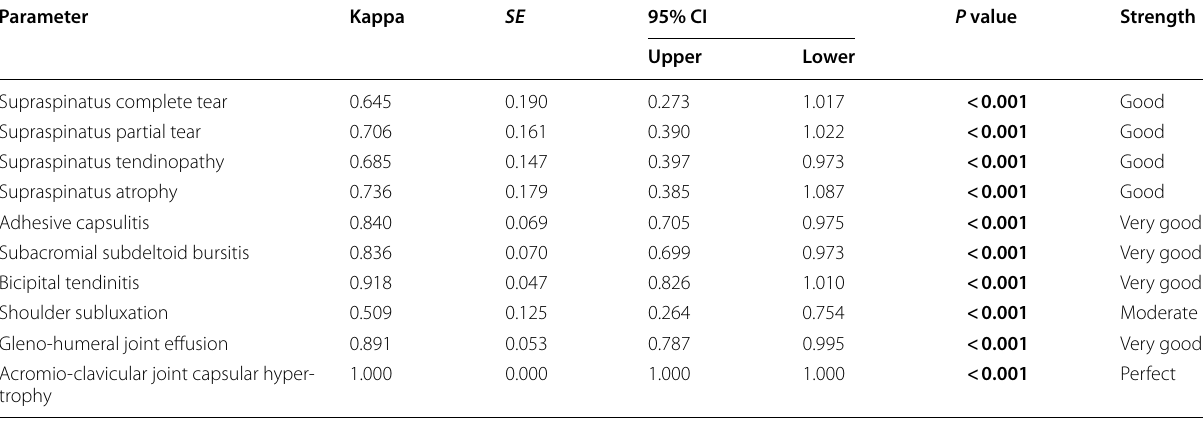
Bold indicates that p value